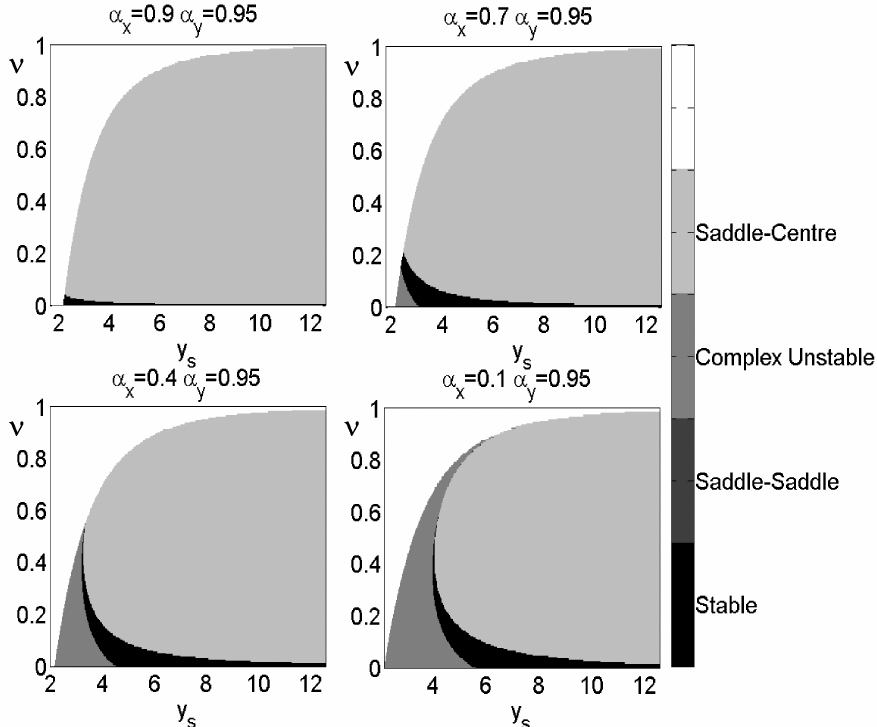
Fig. 4. Behaviour of Lagrange point L 3 in the short axis equilibrium configuration for different shape parameters α x and α y , going from a very spherical body to a very elongated body, from left to right and top to bottom. The white region corresponds to the case where L 3 is inside the sphere circumscribing the elongated body, for which our equations are not